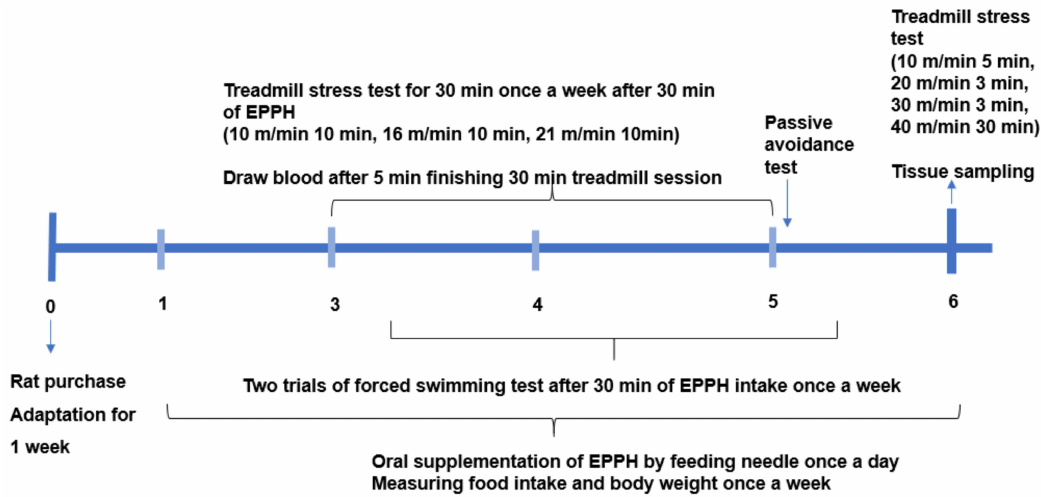
Figure 1. Experimental design. Rats had oral supplementation of EPPH (0.08, 0.16, and 0.31 mL/kg body weight) by a feeding needle once per day for two weeks, and from the third week, rats were given intense exercise using a treadmill protocol for 30 min after 30 min of being given EPPH. However, rats in the no-exercise group did not have intense exercise. The treadmill exercise was conducted for two weeks according to the protocol 10 m/min for 10 min, 16 m/min for 10 min, and 21 m/min for 10 min. Two days after the treadmill exercise, they were given a forced swimming test 30 min after EPPH supplementation. In the fourth week after starting the treadmill, the final treadmill test was performed according to the protocol of 10 m/min for 5 min, 20 m/min for 3 min, 30 m/min for 3 min, 40 m/min for 30 min, and after 5 min, rats were sacrificed for collecting their